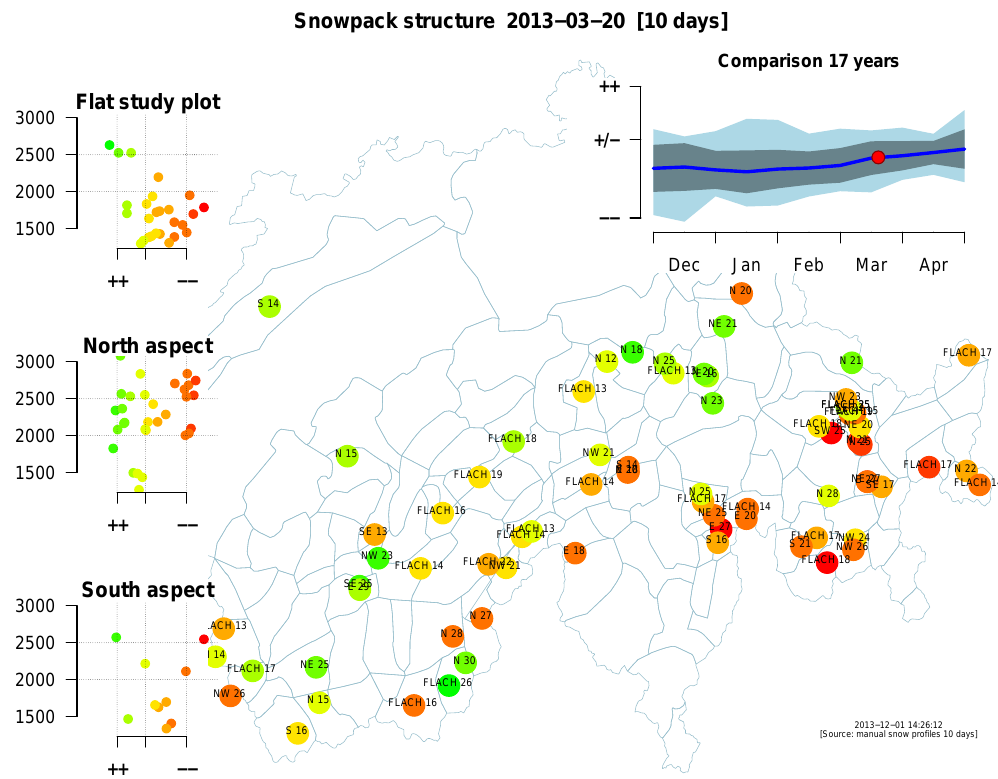
Fig. 4. Map of Switzerland showing the locations where manual profiles were observed (main graph, coloured points). Colour coding corresponds to the five classes calculated from SNPK index (red: unfavourable (– –); yellow: medium ( ± ); green: favourable ( ++ )). Each point represents one profile with the slope aspect and elevation given (e.g. N 15 is north aspect at 1500m). In the background the shapes of the 120 forecast regions are shown. The insets on the left side of the plot show the profiles according to aspect and elevation. The inset in top right corner gives a comparison of the actual conditions (red point) with the previous 17 years, where the mean is the blue line; the grey-shaded areas are ± 1 standard deviations from the mean and the light-blue-shaded area the minima and maxima during this